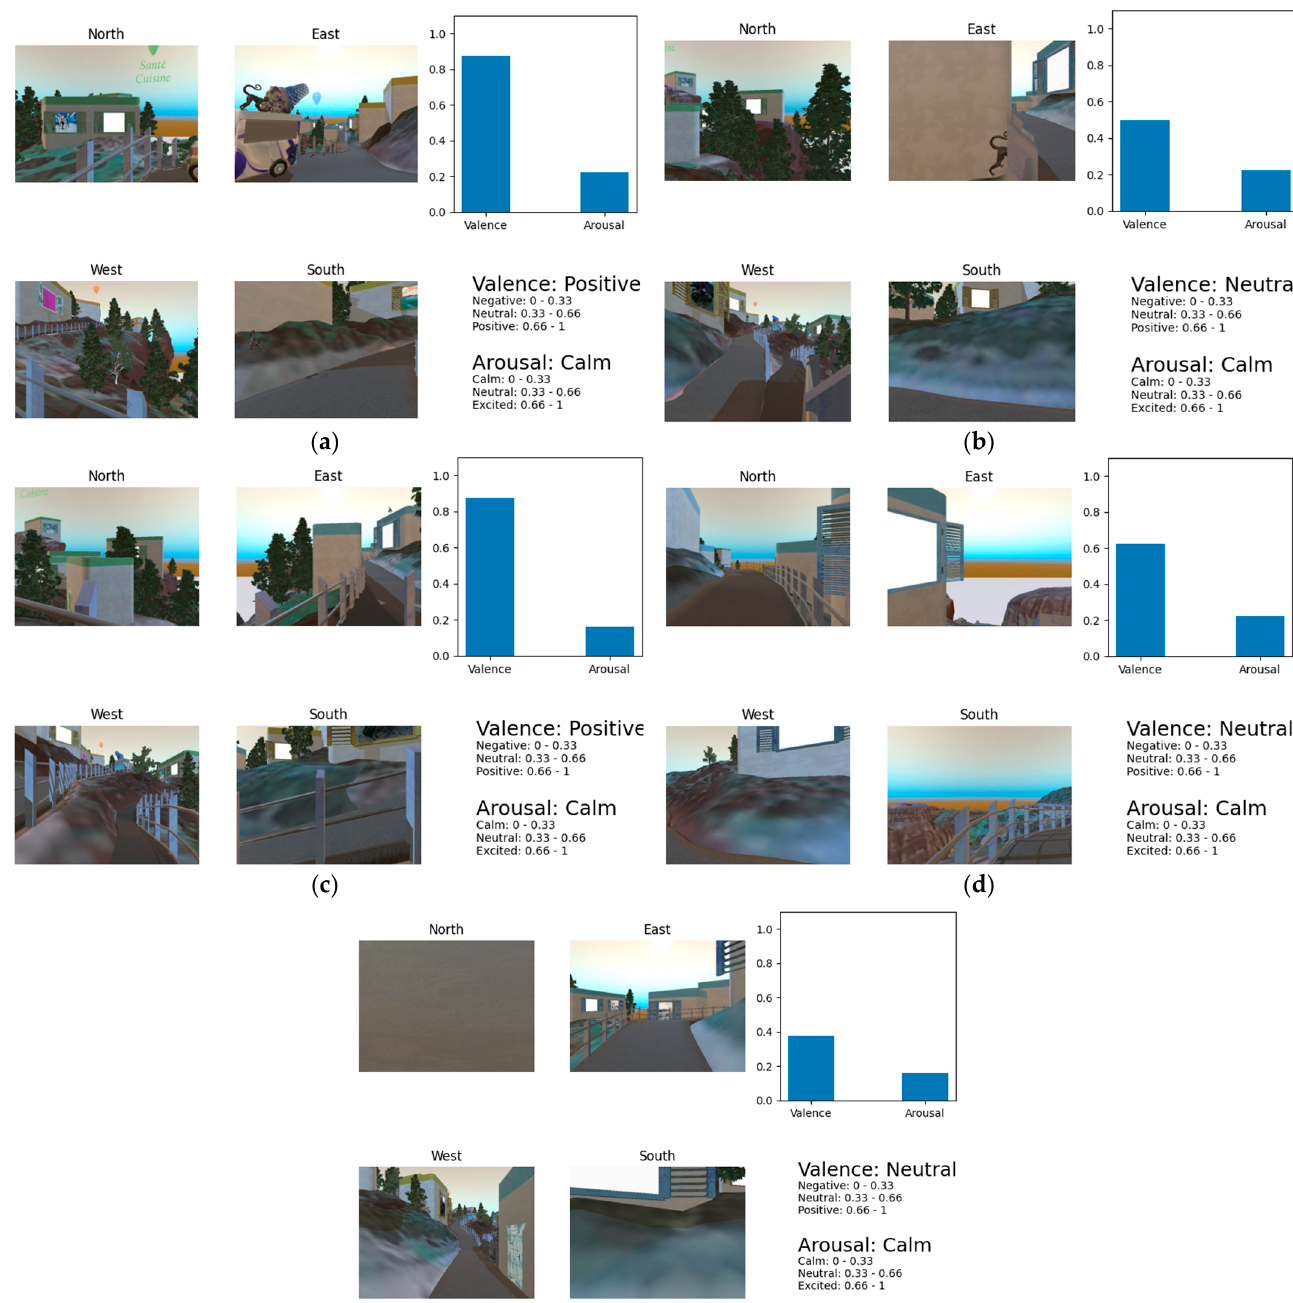
more during the experiment.